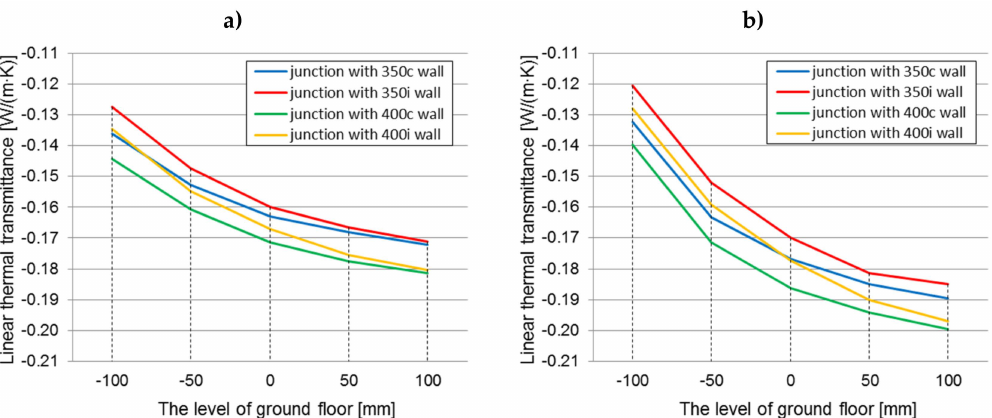
Figure 9. Linear thermal transmittance coe ffi cient (calculated using the external dimensions) of the ground junction in all construction variants of walls filled with hemp–lime composite ( λ = 0.080 W / (m · K)) dependent on the floor level on the ground: ( a ) floor on joists; ( b ) self-supporting